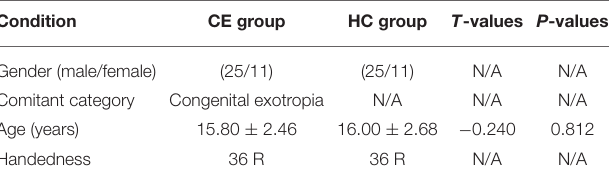
TABLE 1 | Clinical indicates between two